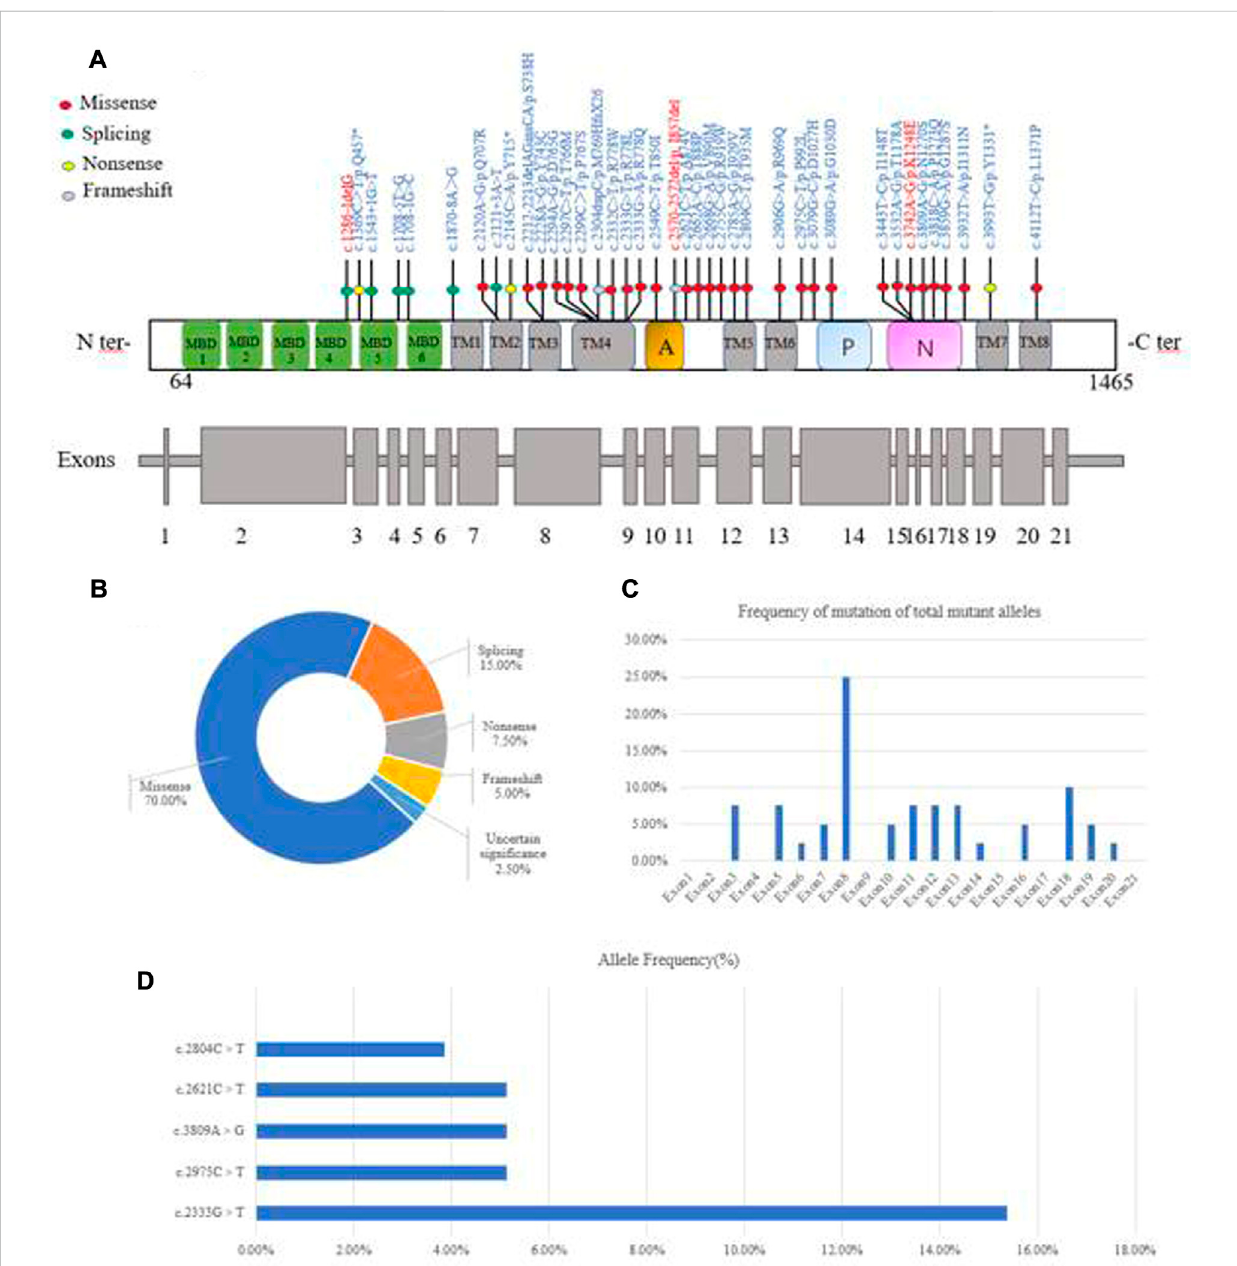
FIGURE 3 Characterization of genetic mutations in the ATP7B gene. (A) Novel mutations were observed. (B) Various mutants identi fi ed in this study and their percentage. (C) The frequency ofmutations foundinthe39WDpatientsisgiven perexon asapercentageofthetotalmutantalleles. (D) Allelefrequency of common ATP7B mutations in Yunnan province. MBDs, metal binding domains; Transmembrane segments are numbered TM1 to TM8; A: actuator domain; p : phosphorylation domain; N: nucleotide-binding